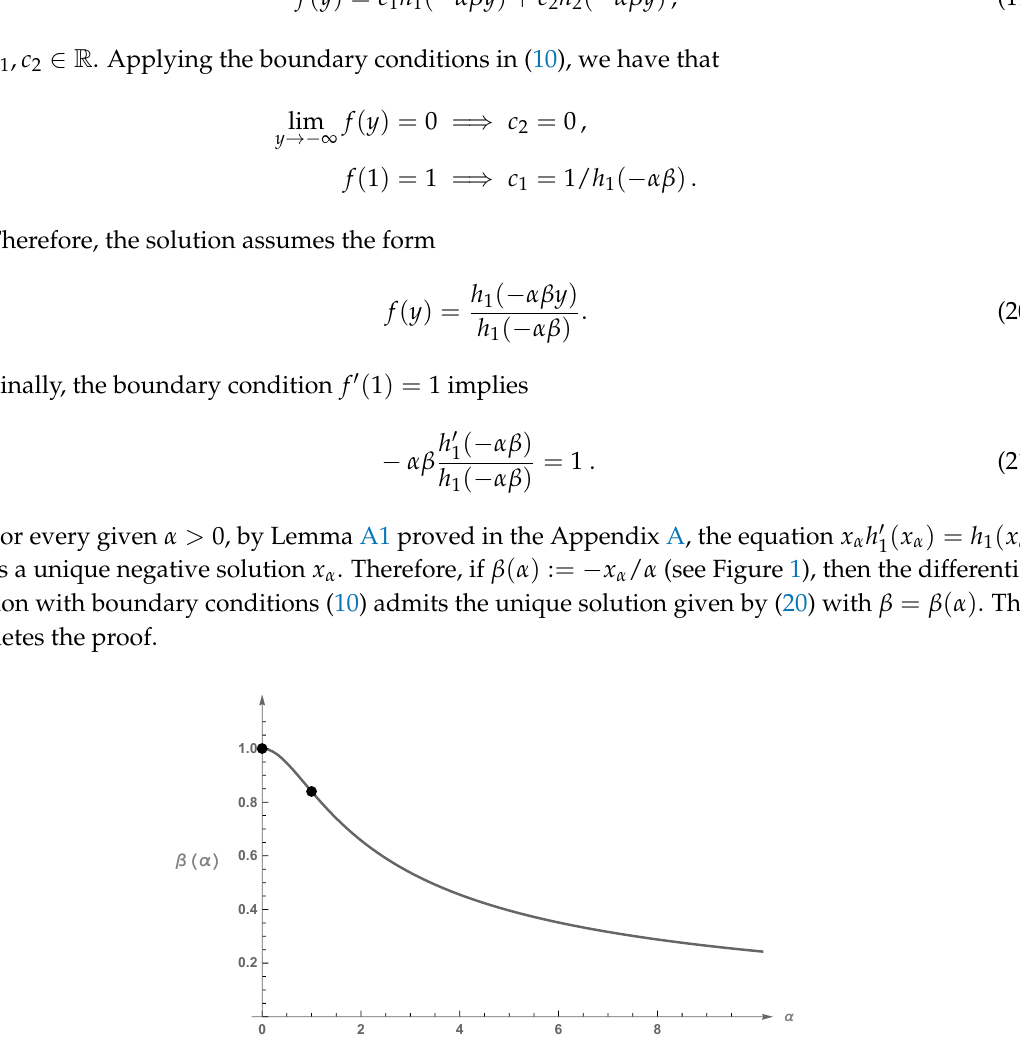
Figure 1. Plotting β as a function of α . The marked points are β ( 0 ) = 1 and β ( 1 ) ≈